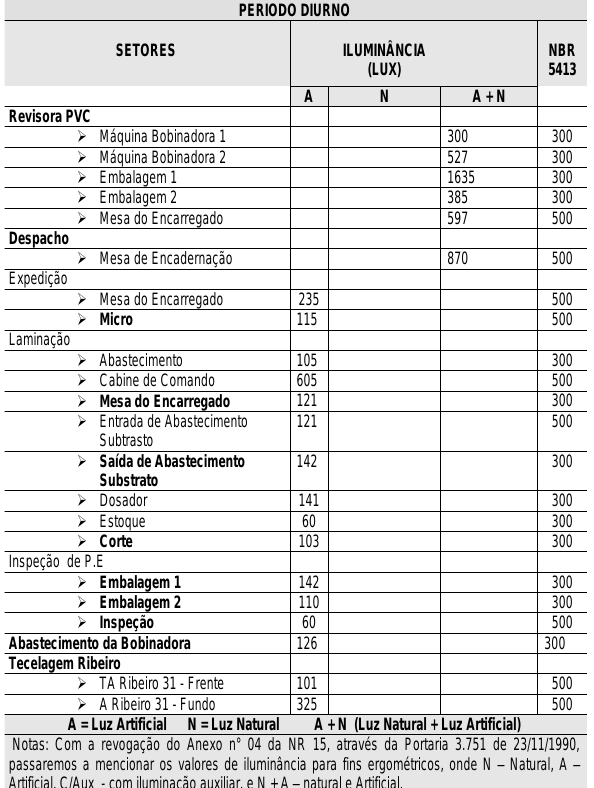
Tabela 2: Avaliação Quantitativa de Níveis de Iluminância (Lux) – Segurança N° 03 – Período